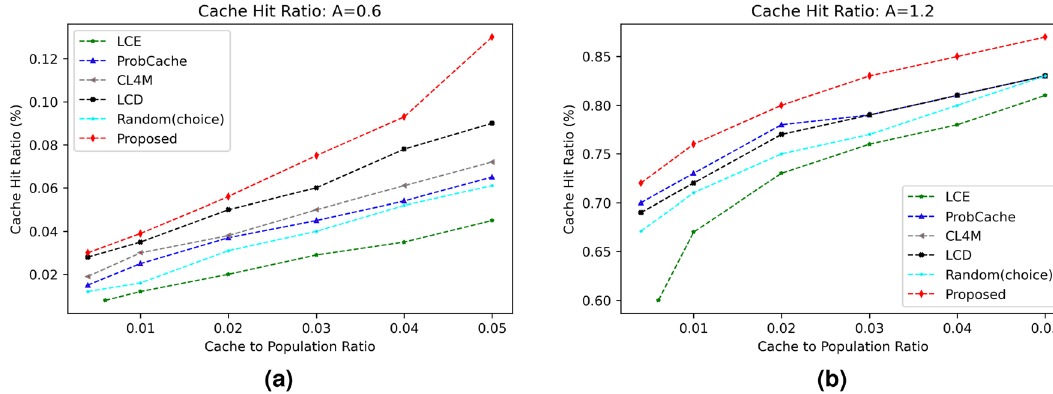
Figure 2. Influence of cache size on CHR.